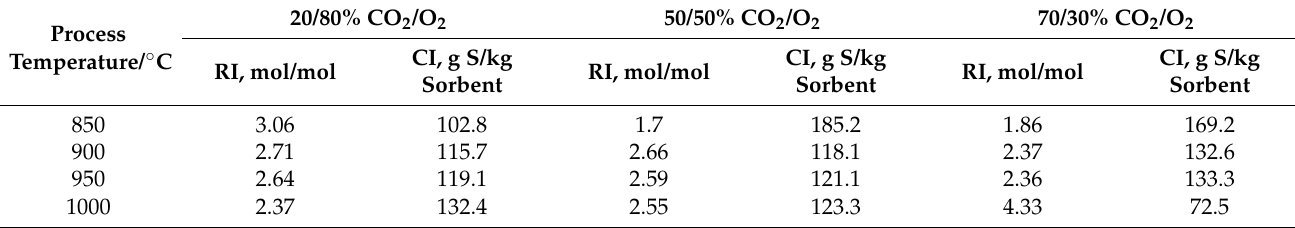
Table 6. Calculated coefficients of reactivity and absolute sorption for the tested sorbent samples. Process